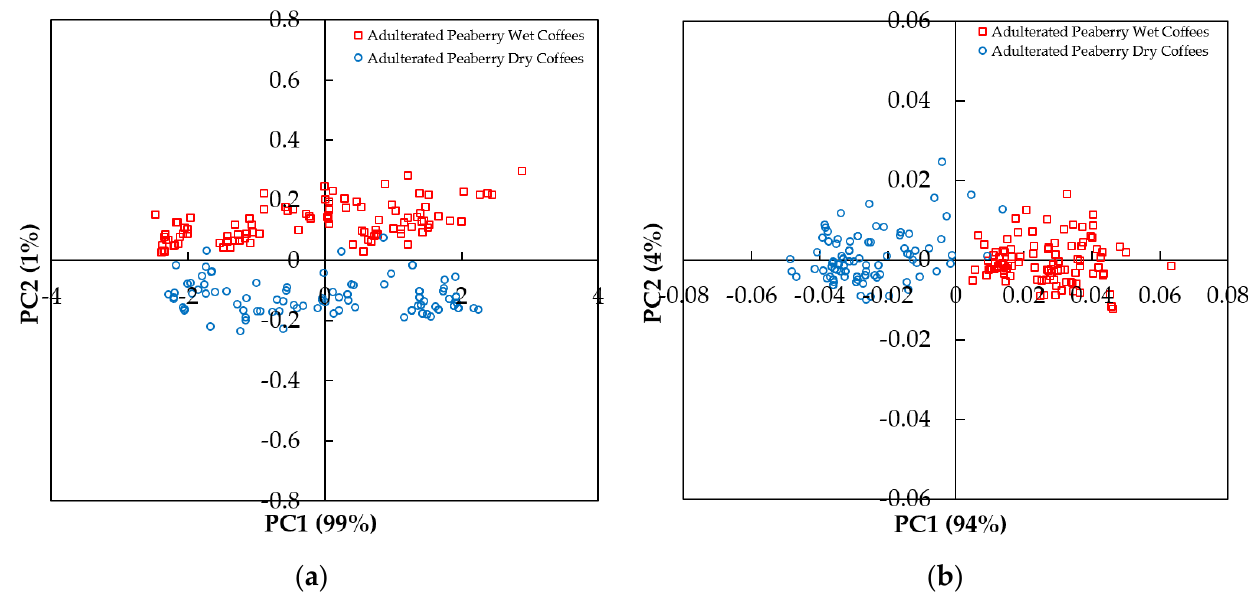
Figure 3. Plot of the first two principal components by PCA in the range between 250 and 400 nm: ( a ) raw spectra; ( b ) pre-processed spectra (MAS + SNV + SG1d).